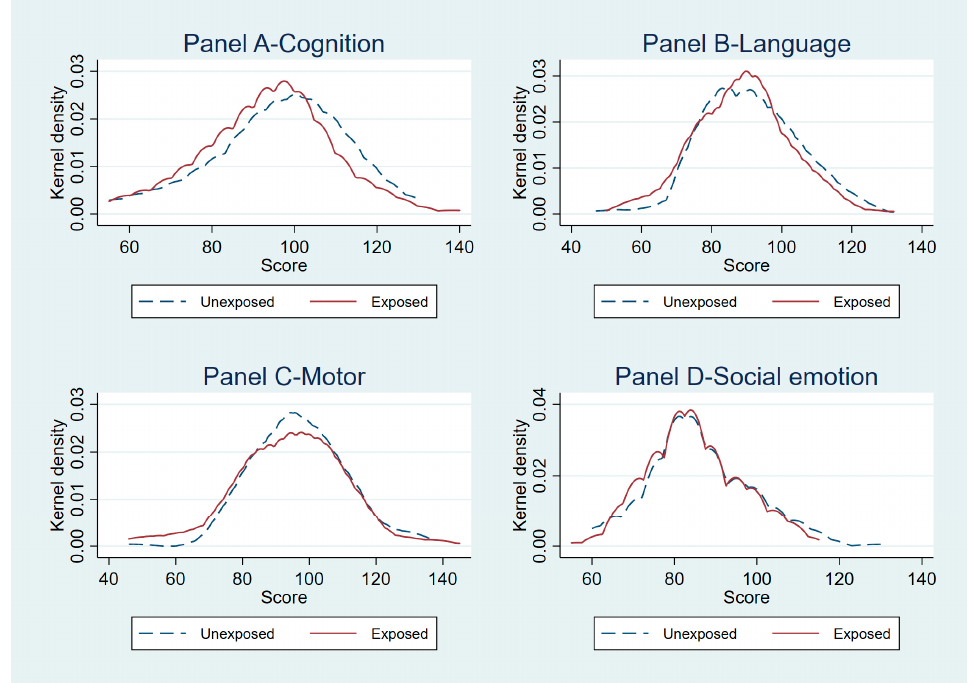
Figure A1 . The distribution of the Bayley Scales of Infant Development III (BSID-III) test score among children with and without ETS (environmental tobacco smoke) exposure during pregnancy.